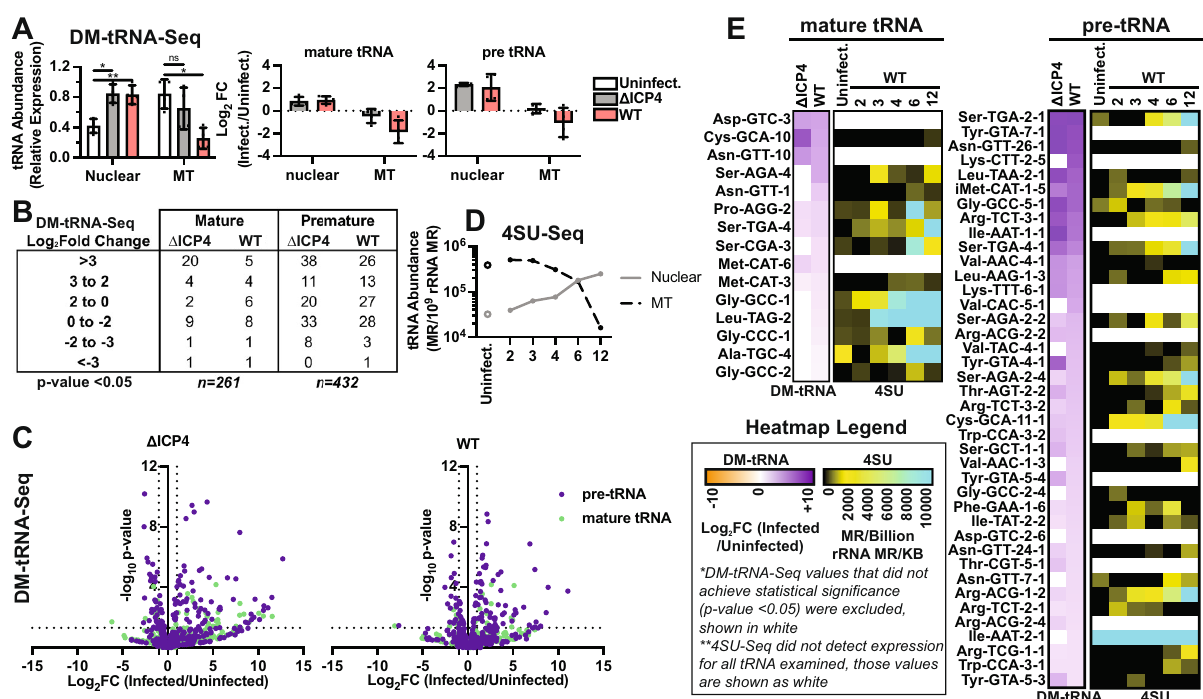
Fig. 2 Alteration of the tRNA landscape by HSV-1 Productive Infection. We performed DM-tRNA-Seq on human fi broblasts that were mock-infected or infected with Δ ICP4 (n12) or wildtype HSV-1 (KOS) for 12 h. Data was normalized to an internal spike-in control and the size in kilobase pairs (KB) of each tRNA (mapped reads per million spike-in reads per KB, MR/MSI/KB). For 4SU-Seq, human fi broblasts were mock-infected or infected with wildtype HSV-1 and RNA was isolated at 2, 3, 4, 6, or 12 hpi. 4SU was pulsed in for 15 min at the time (hpi) indicated to label nascent RNA. Data was normalized to rRNA and the size of each tRNA (mapped reads per billion rRNA mapped reads per KB, MR/10 9 rRNA MR/KB). A Uniquely mapped DM-tRNA-Seq reads normalized to spike-in controls and delineated as those encoded by the nuclear or mitochondrial (MT) genome. Values are relative to the sample set max. Statistical values were generated from a paired t -test, where * indicates a p -value of < 0.05, or ** < 0.01. Data bars are the average, error bars are standard deviation and individual data points represent experimental replicates ( n = 4). B , C Differential expression analysis (edgeR, p -values adjusted for multiple testing by Benjamini-Hochberg) for DM-tRNA-Seq data, requiring a p -value threshold of 0.05 to achieve signi fi cance. Values are log 2 fold change (infected/uninfected) versus the false-discovery rate (FDR) p -value. D Uniquely mapped 4SU-Seq reads normalized to rRNA and delineated as those encoded by the nuclear or mitochondrial (MT) genome. E Heatmaps for upregulated mature- and pre-tRNA. Differentially expressed (DE) mature-tRNA were de fi ned using our DM-tRNA-Seq data (analysis described in C ) as p -value < 0.05, log 2 fold change (HSV-1/uninfected) > 0.5. DE pre-tRNA were de fi ned as p -value < 0.05, log 2 fold change (HSV-1/uninfected) > 2. DM-tRNA-Seq data was plotted as log 2 fold change (WT HSV-1 infected/uninfected); data with a p -value >0.05 was not plotted and is white in the heatmaps. 4SU-Seq data was plotted as MR/Billion rRNA MR/KB, any tRNA not detected in our data were plotted as white in the ICP4, ICP27, ICP0, and ICP22 are viral IE proteins with various roles in promoting viral gene expression. UL30 is the viral DNA polymerase required for genome replication. Single-deletion mutants for the viral IE proteins — ICP4, ICP27, ICP22, ICP0 —